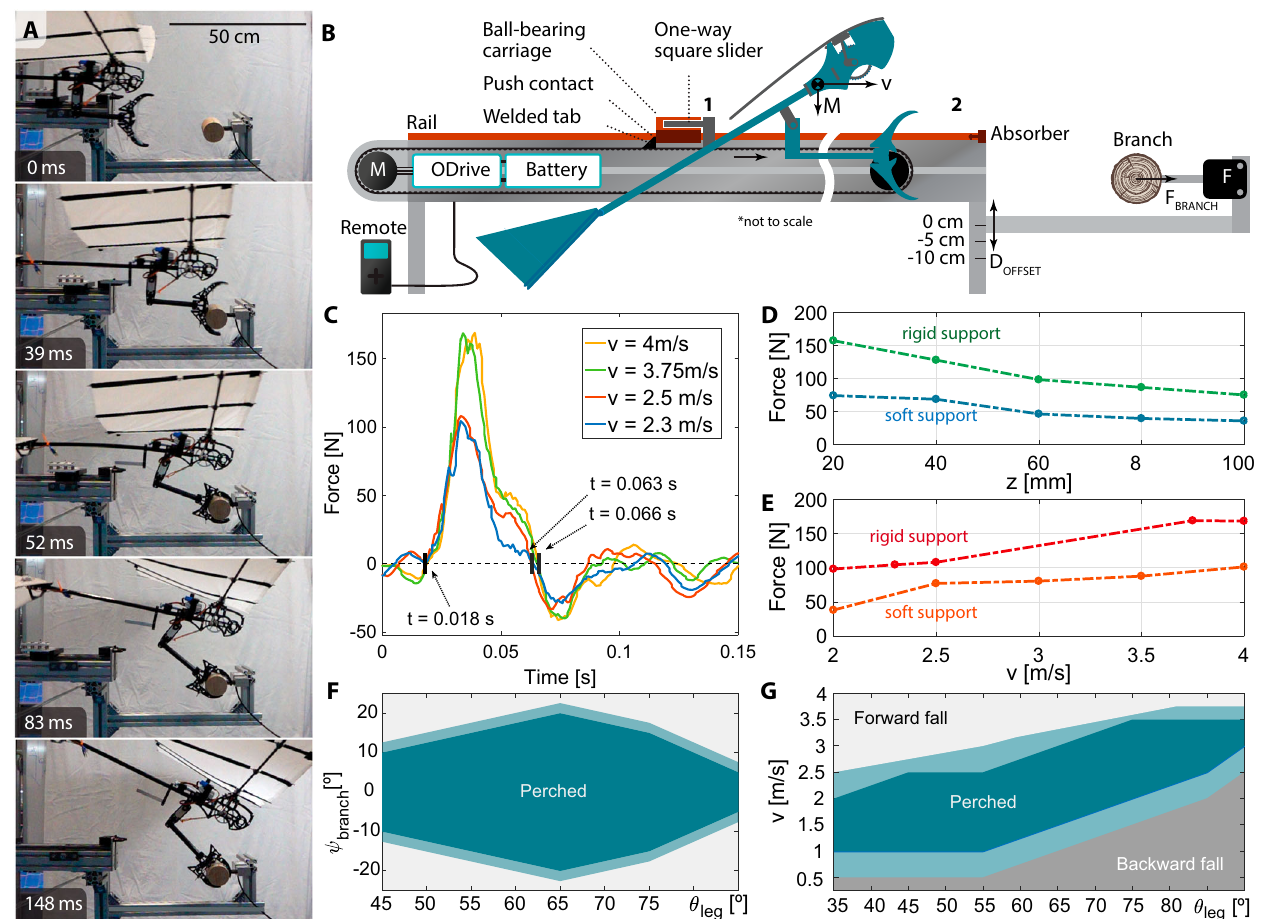
Fig. 5| Evaluation ofperchingcapability. A Timeframes of the approaching leg- clawsystemand thetest robotwith similarmass to the fl ight version. B Launching experimentssetupwiththerobotintheaccelerationposition 1 ,thereleasedpoint 2 , and the perching point. C Force measurement upon impact at different speeds. D Force measurement as a function of misalignment. E Force measures as a function of speed. F Perching success region considering leg angle θ leg versus velocitymagnitude.Theperchingspaceisdividedintothreeregions:1,thesystem